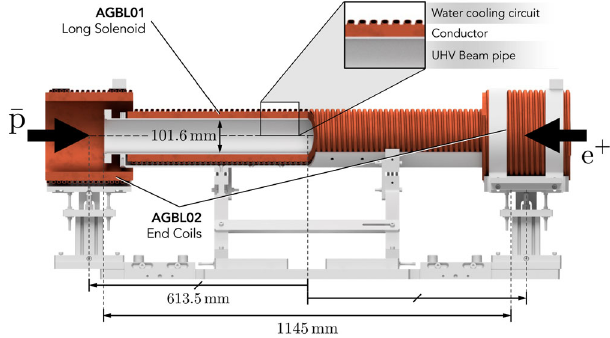
FIG. 4. Diagram showing the cross section of an ALPHA beamline module. Copper conductors and water cooling circuits are highlighted in orange, while the UHV beam pipe and its surrounding support structures are shown in